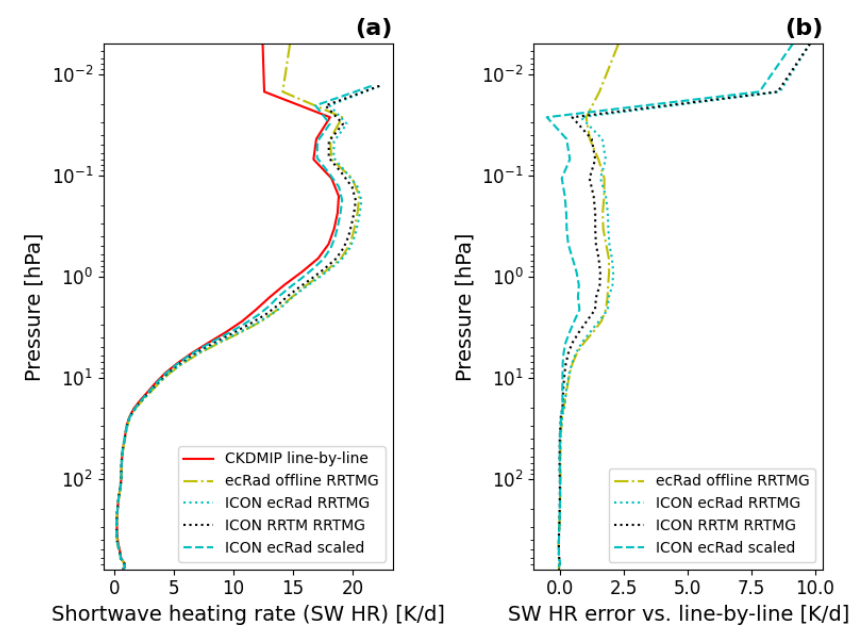
Figure 11. Comparison of shortwave radiative heating rates for Column2 of the CKDMIP Evalua- tion1 dataset, showing exact line-by-line results and offline ecRad results from CKDMIP and ICON SCM results using both the new ecRad and the old RRTM radiation scheme with old RRTMG solar spectrum and ICON SCM with ecRad and the new scaled solar spectrum. Profiles of ( a ) shortwave heating rates and ( b ) errors in shortwave heating rates compared to the line-by-line